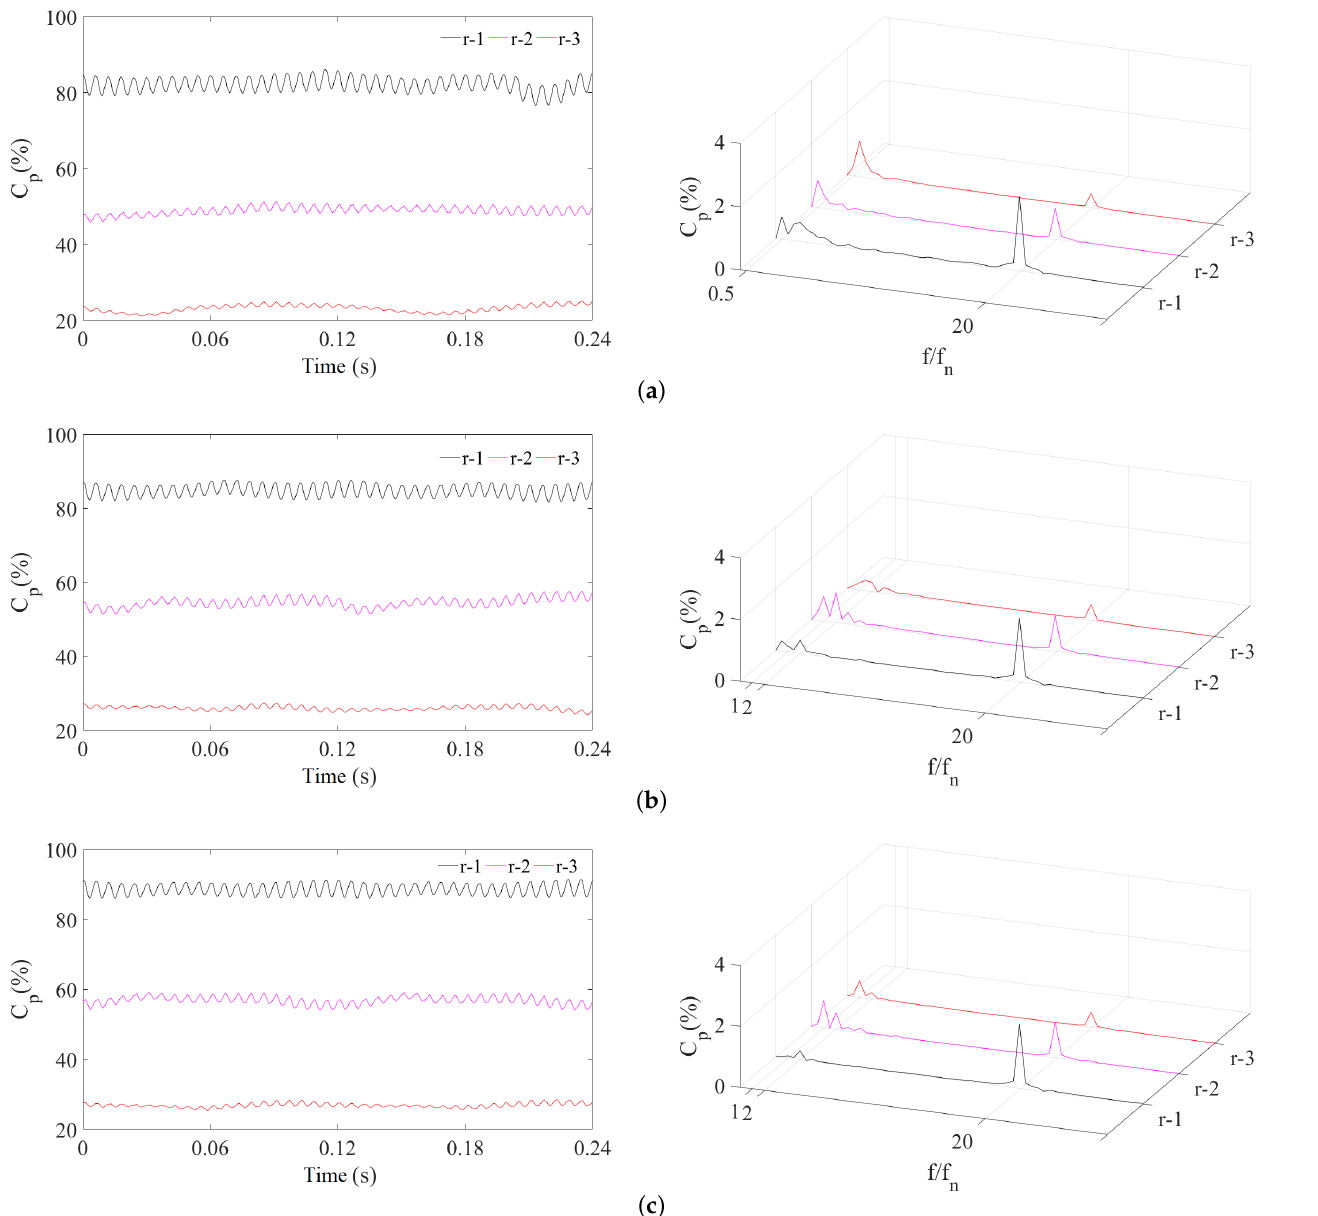
Figure 20. Time–domain and frequency–domain diagrams of pressure fluctuations of the monitoring points along the runner passage. ( a ) 60% load condition. ( b ) 86.7% load condition. ( c ) 100% load